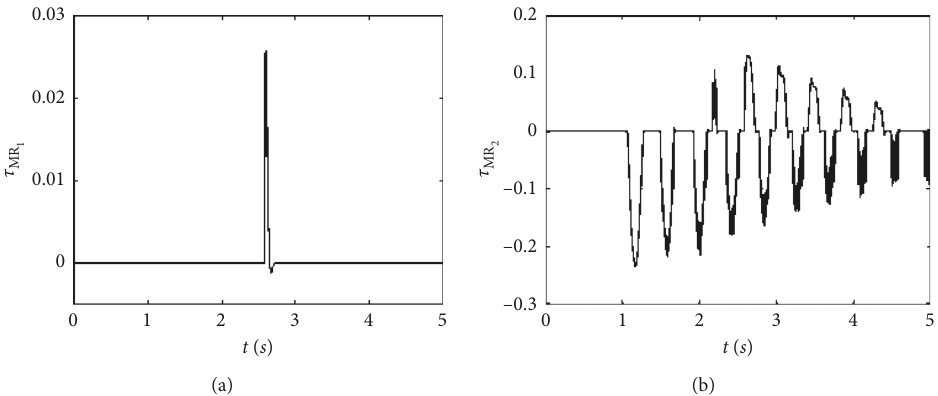
Figure 17: (a) Torque control MR brake joint one. (b) Torque control MR brake joint